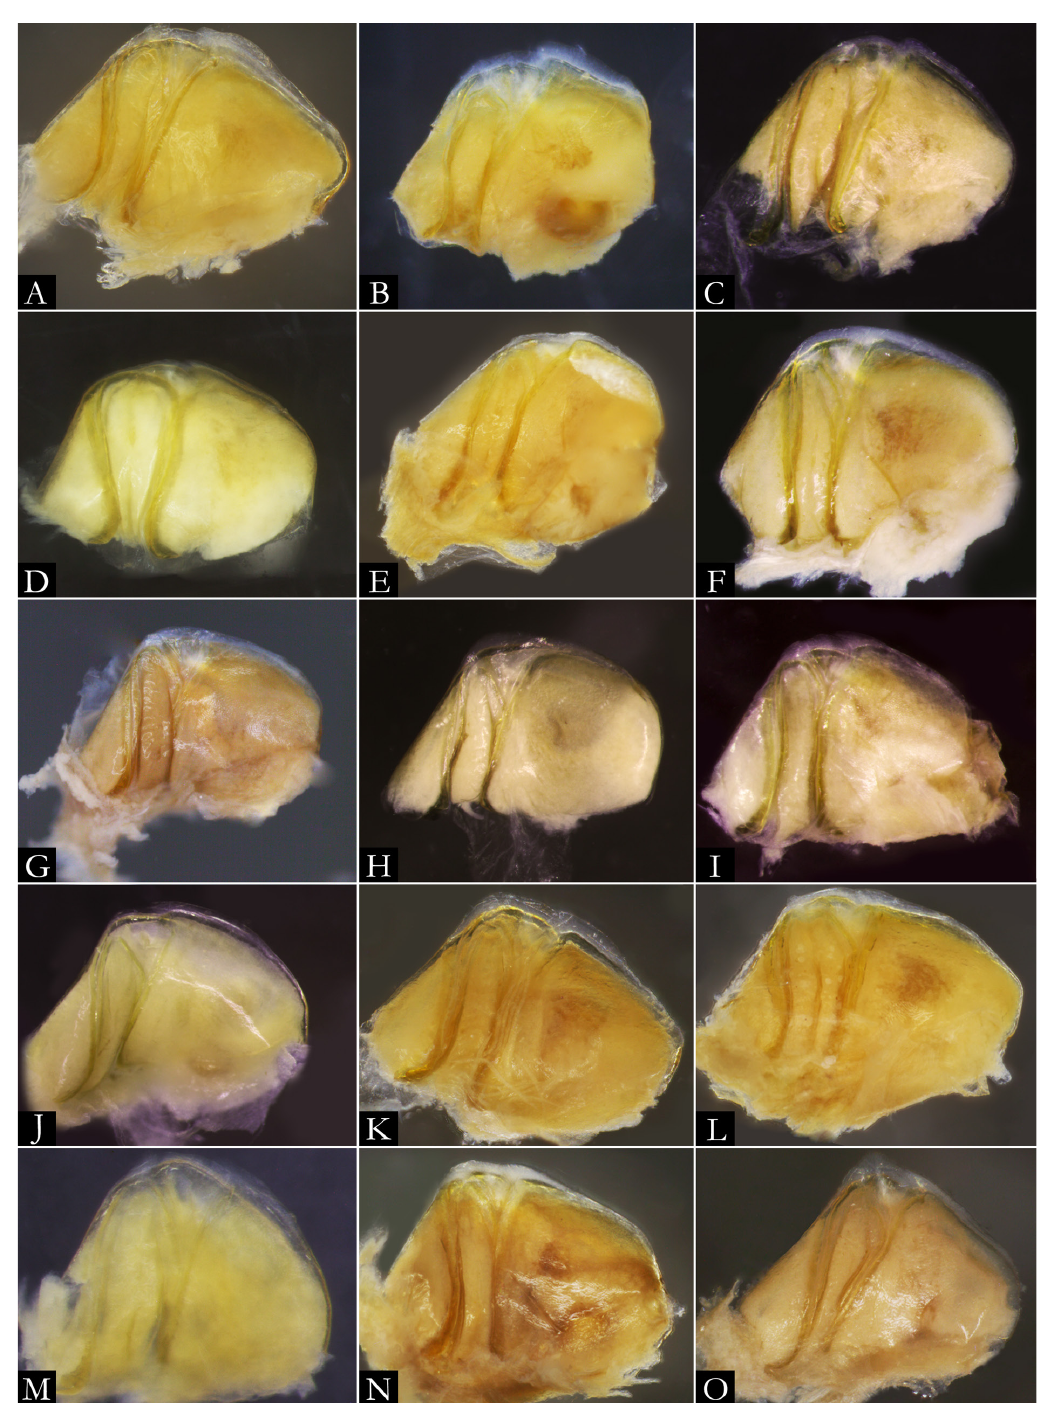
Fig. 177. Stereoscopic images of left vulva of species of Pseudonannolene Silvestri, 1895, in oral